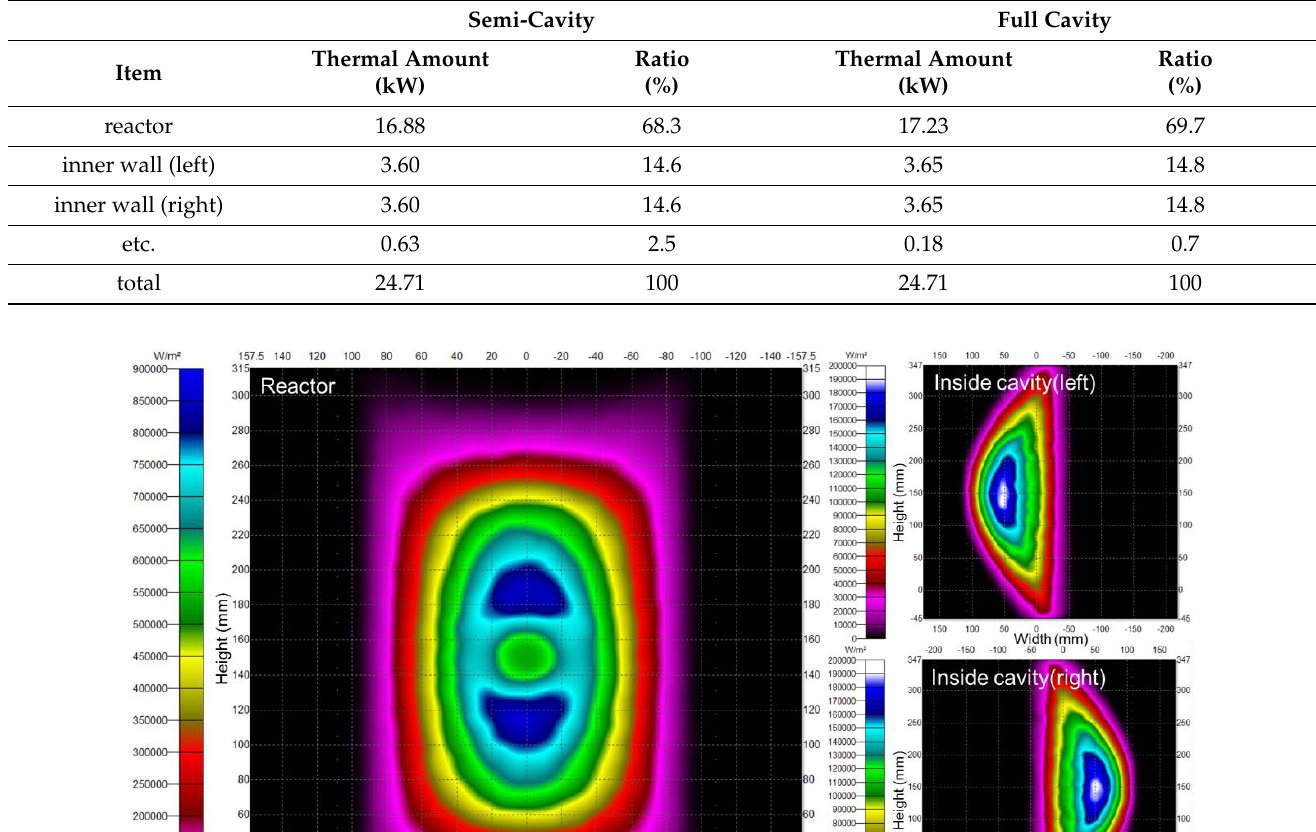
Figure 13. Sun ray distributions in semi-cavity ( left ) and full cavity ( right ).